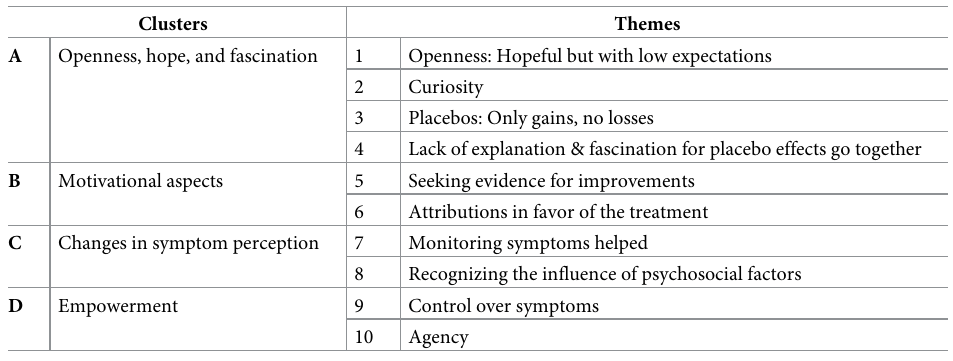
Table 2. Clusters and